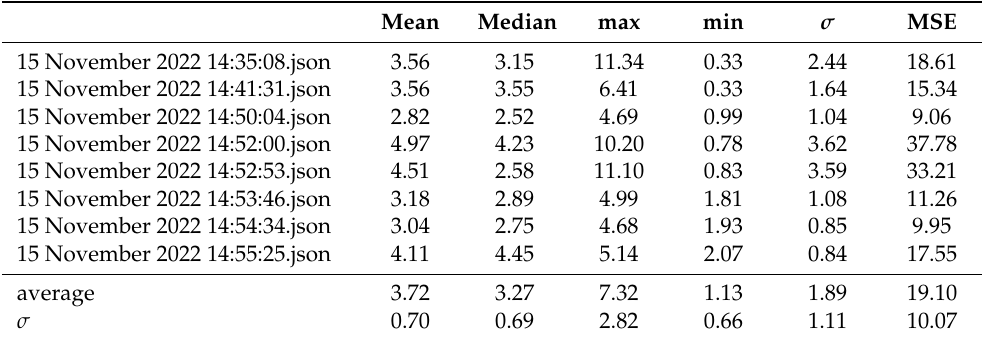
Table 6. Evaluation (Dataset 2): beacon; distance to correct point on the ground truth.